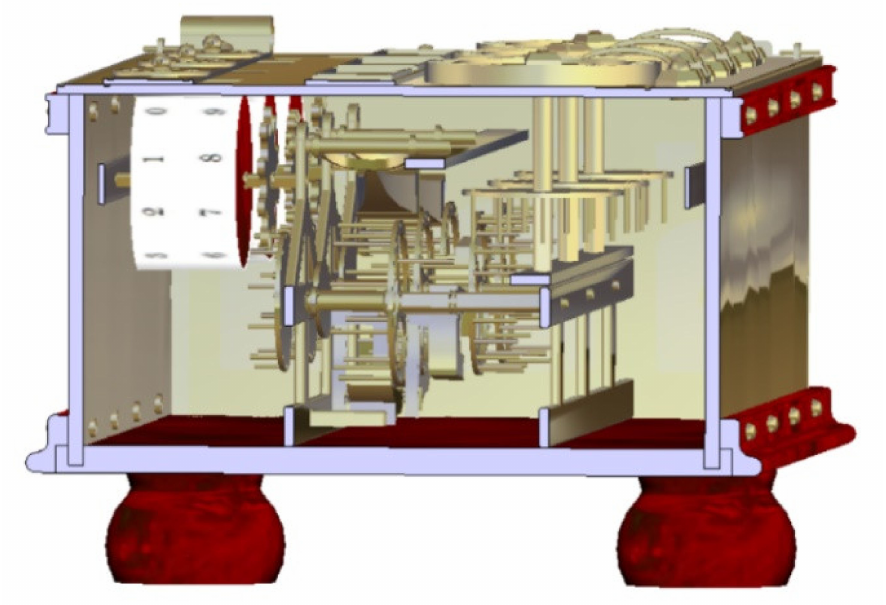
Figure 27. Perspective of the sectioned model.